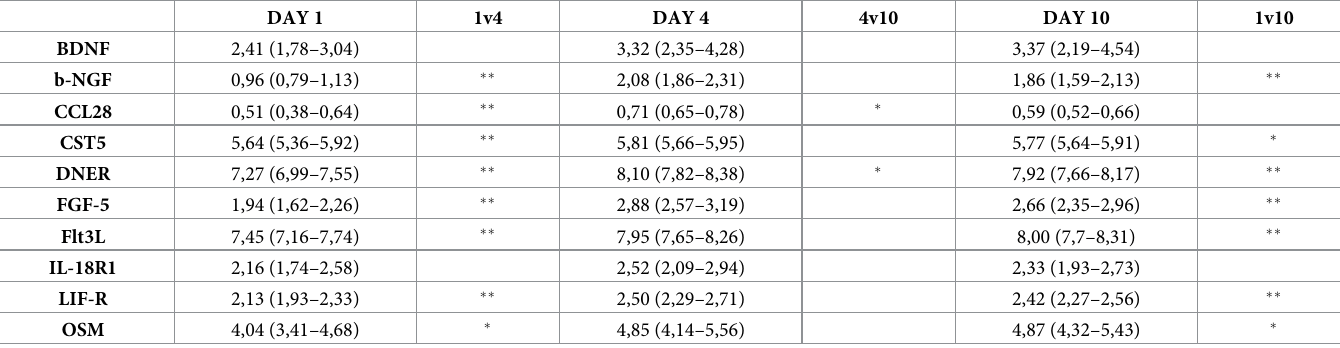
Table 4. Group B proteins.